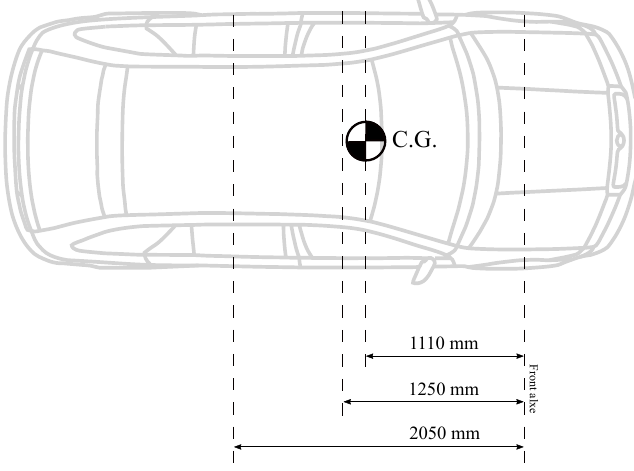
Figure 7. Initial empty car.